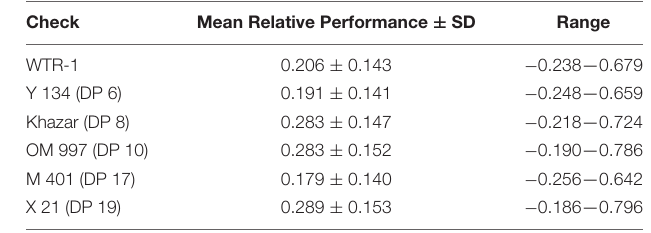
TABLE 4 | Model prediction accuracy and standard error for male GCA for each trait as estimated by ten-fold cross-validation.